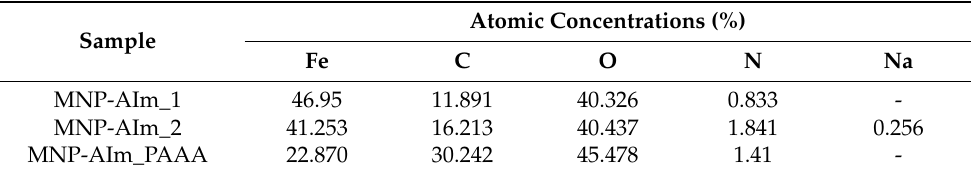
Table 1. The atomic concentrations (%) were calculated from XPS spectra for MNP-AIm_1, MNP- AIm_2 and